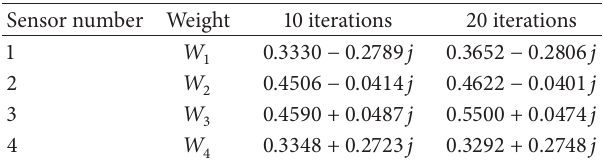
Figure 4: Number of iterations with SINR of DM-AIS for one user at 40 ∘ and interference at 50 ∘ and 30 ∘ by using 4 elements. Table 3: Weight vector for two users with four interferences using